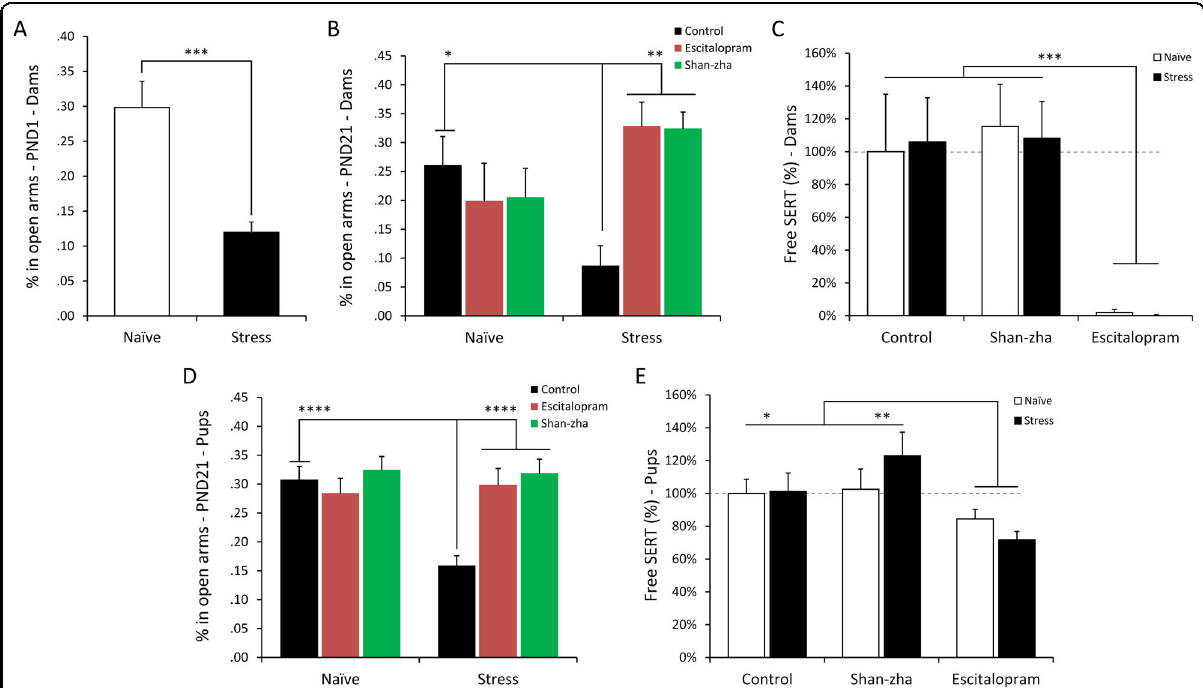
Fig. 3 Anxiety-like behavior and escitalopram concetrations in dams and pups. A Antenatal stress-induced anxiety-like behaviors in dams, on PND 1. n = 15 dams per group. B Antenatal stress had a lasting effect on dams ’ anxiety-like behavior, which was ameliorated by chronic treatment with either escitalopram or shan-zha. n = 5 dams per group. C Dams treated with escitalopram demonstrated reduced [ 3 H]citalopram binding compared to control- and shan-zha-treated dams, indicating increased serum escitalopram level. n = 4 dams per group. D Pups that were exposed to stress during gestation demonstrated increased anxiety-like behavior on PND 21; maternal treatment with either escitalopram or shan-zha ameliorated the anxiety-like phenotype. n = 35 – 39 pups per group. E Pups of dams that were treated with escitalopram demonstrated increased serum escitalopram levels. n = 14 – 16 pups per group. Dashed lines represent means of reference groups (i.e., control-naïve groups). * p <0.05, ** p <0.01, *** p <0.001, **** p